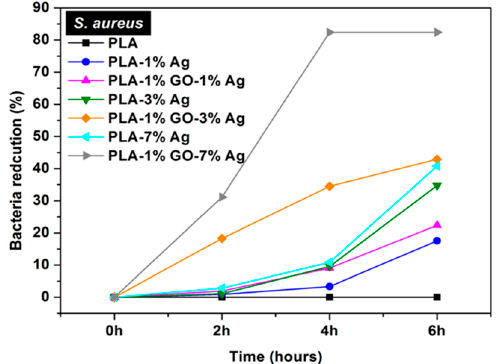
Figure 14. Bacterial reduction percentage vs. time profiles for S. aureus culture medium inoculated with electrospun PLA and its nanocomposite mats. Reproduced with permission from [165], Copyright American Chemical Society, 2017.